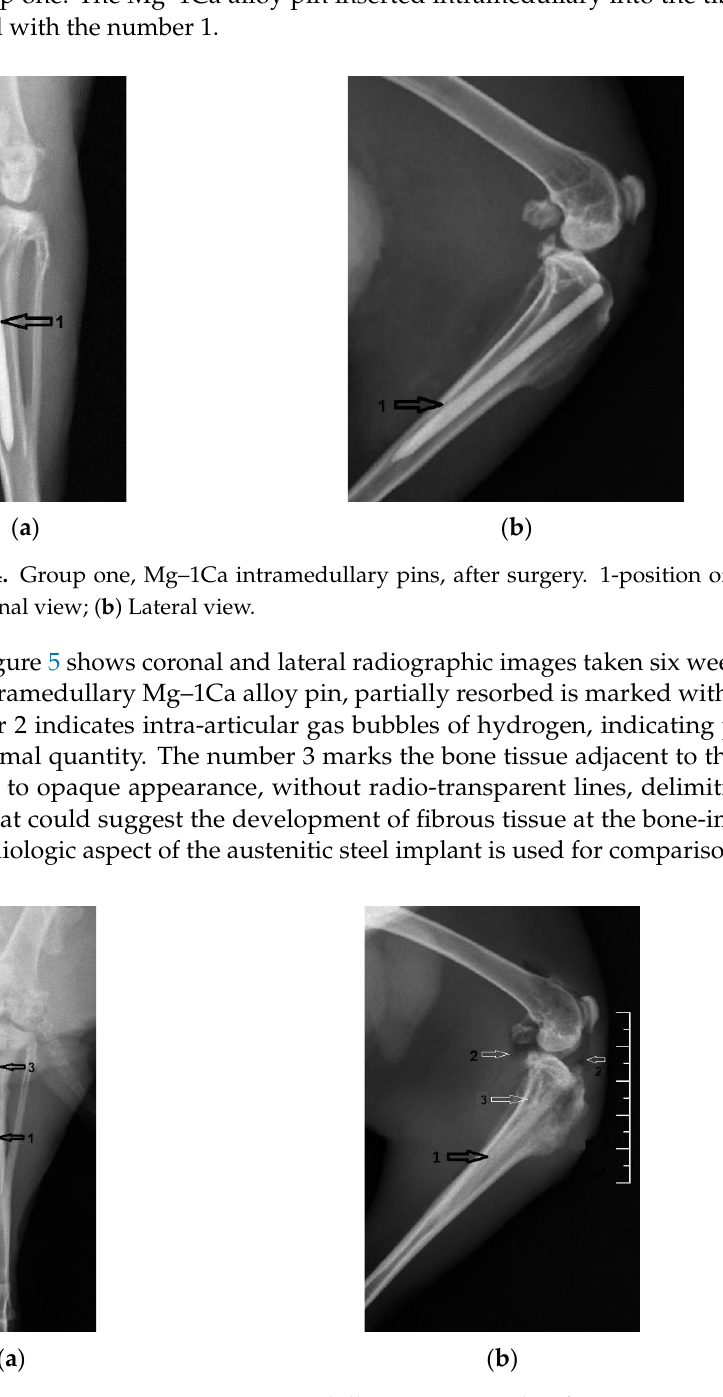
Figure 5. Group one, Mg–1Ca intramedullary pins, 6 weeks after surgery. 1-Mg-1Ca alloy pin with partial resorbtion, 2-Pneumoarthrosis indicated by intra-articular gas bubbles, 3-Fibrous tissue formation formed at the bone-implant interface. ( a ) Coronal view; ( b ) Lateral